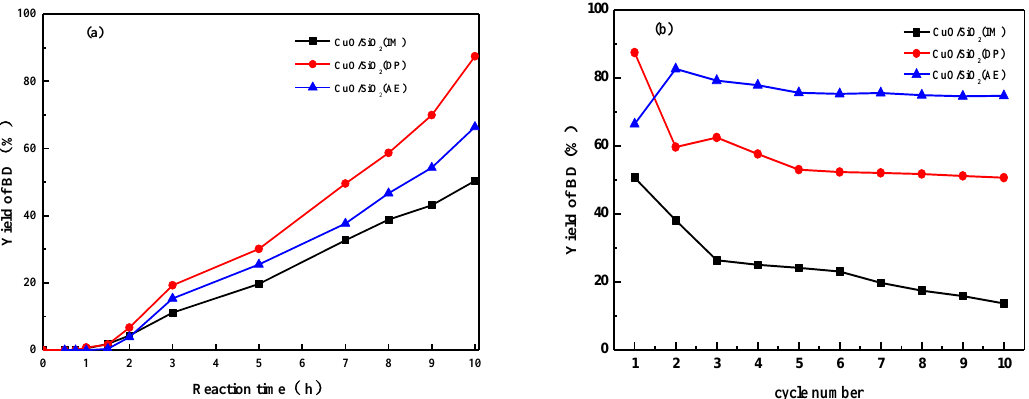
Figure 10. Yields of 1,4-butynediol (BD) using various CuO / SiO 2 catalysts as functions of ( a ) reaction time and ( b ) cycle number. Reaction conditions: catalyst amount of 0.5 g, formaldehyde solution concentration of 35 vol.%, consumption of the formaldehyde solution of 50 mL, and reaction temperature of 90 °C.